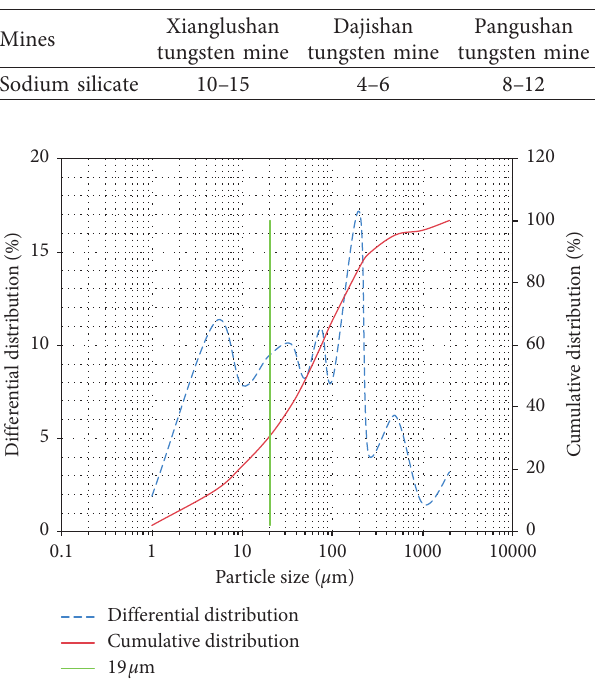
Figure 1: Muddy foams on the liquid surface in XTM: (a) initial operation; (b) after 7 days. Table 1: Sodium silicate added during the mineral process (kg per ton of original ore).